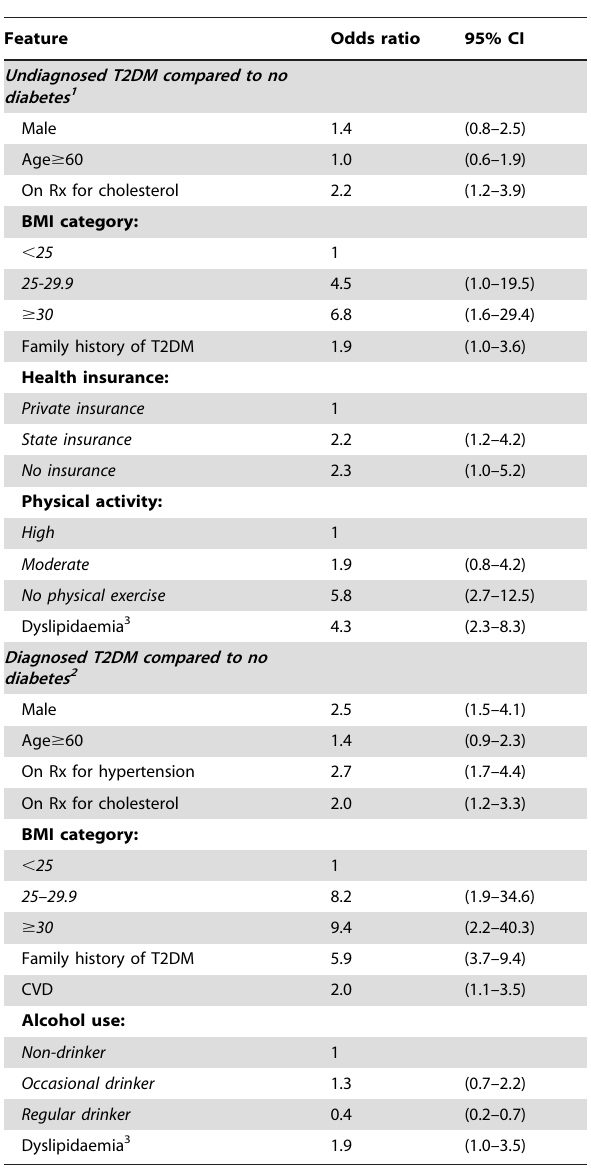
Table 2. Odds ratios (95% CI) of having undiagnosed or diagnosed type 2 diabetes compared to no diabetes – multivariate logistic regression adjusted for gender, age and all significant